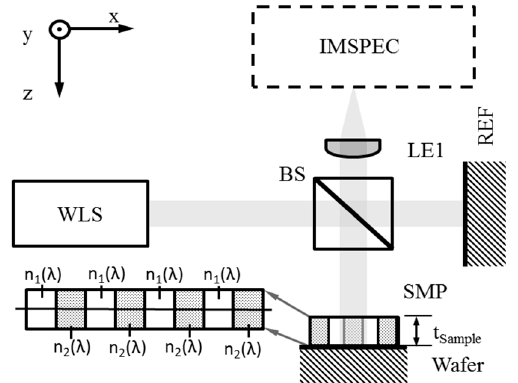
Figure 1. Schematic of the measurement setup with WLS—white-light source, BS—beam splitter, REF—fixed reference mirrors, SMP—sample on a wafer with the thickness t sample and cross section with index n 1 ( λ ) and n 2 ( λ ), LE1—lens to image the sample on the spectrometer, IMSPEC—imaging